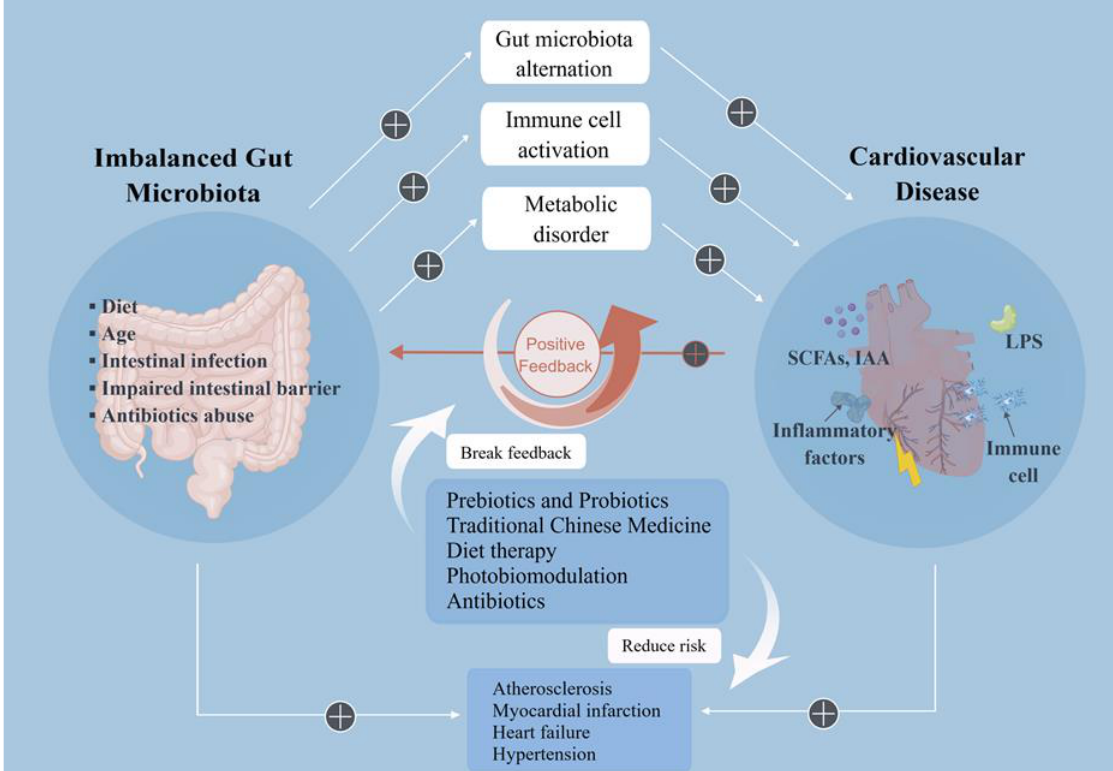
Figure 2. Imbalanced gut microbiota can aggravate cardiovascular disease. Imbalanced gut microbiota caused by dietary habits, age, and antibiotics abuse can aggravate cardiovascular diseases through gut microbiota composition alternation, immune cell activation, and metabolic disorder. The cardiovascular diseases can further promote the disturbance of gut microbiota in return, forming positive feedback. Some treatments like prebiotics and probiotics supplements, TCM, diet therapy, and photobiomodulation can break this feedback and alleviate cardiovascular diseases, such as atherosclerosis, myocardial fraction, heart failure and hypertension. SCFAs: Short-chain fatty acids; IAA: indoleacetic acid; LPS: Lipopolysaccharide. Created with